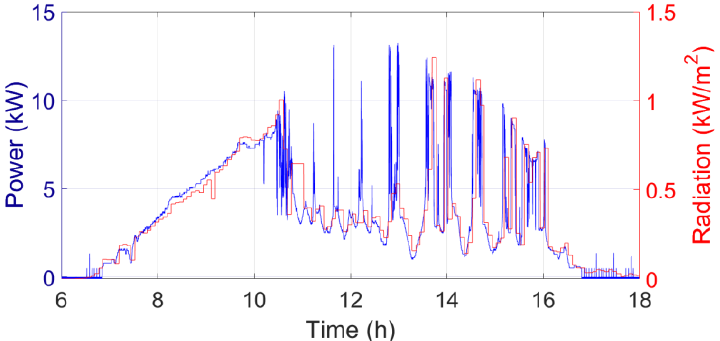
Figure 1. Typical behavior of solar radiation. September 2020. Campus Balzay, Cuenca-Ecuador.